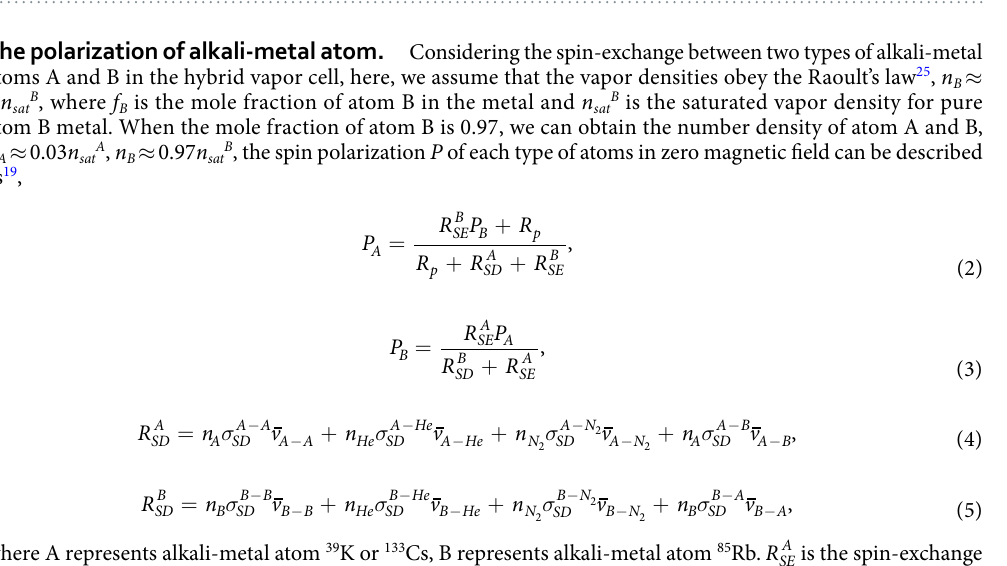
Figure 1. The number density of 39 K, 133 Cs and 85 Rb vary with temperature. Among 39 K, 85 Rb and 133 Cs SERF magnetometers, there is a maximum temperature range for 39 K to make the magnetometer in the SERF regime with the number density of 39 K (black line in squares) satisfies the condition of the SERF regime, so the SERF magnetometer based on 39 K is applicable to the working environment with the temperature varies